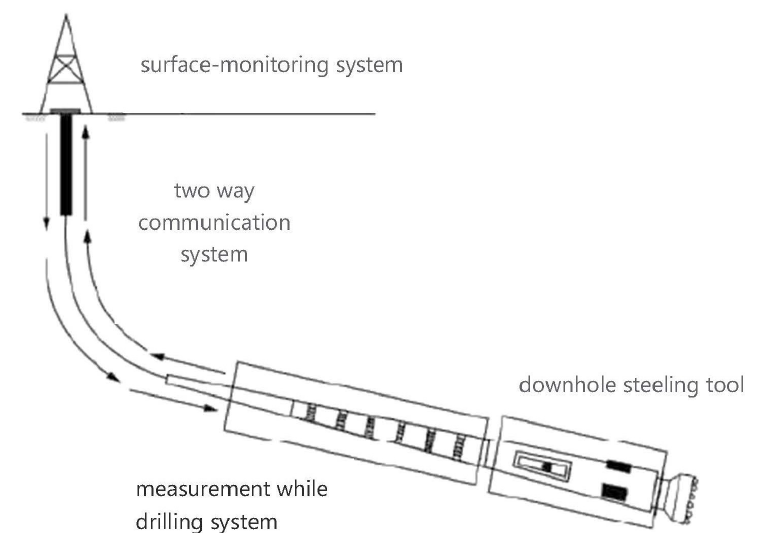
Figure 1. Working principle diagram of the drilling